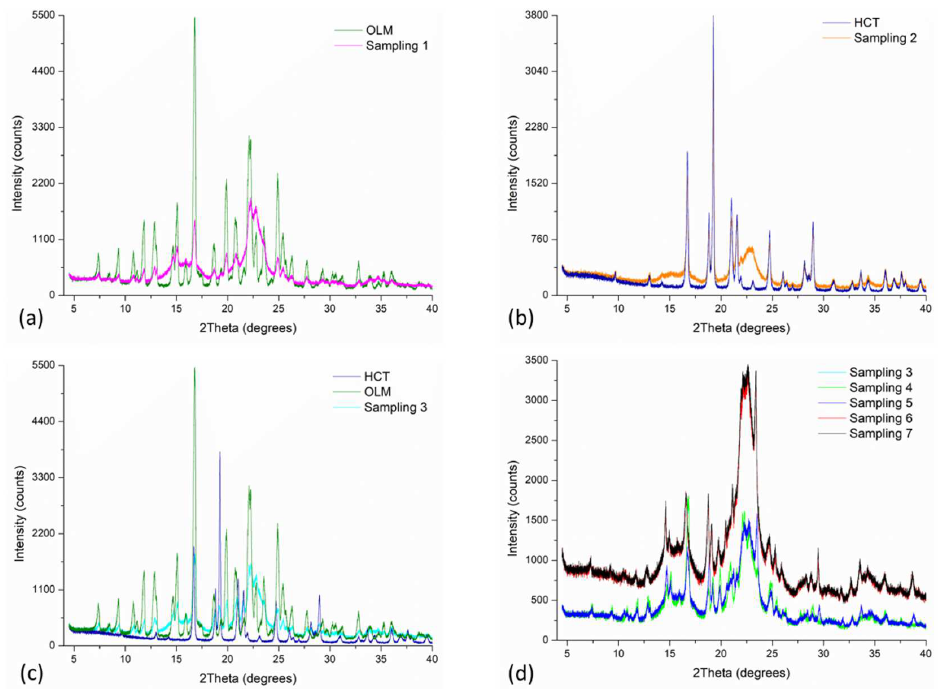
Figure 3. Experimental PXRD patterns of each sampling of F 1 : ( a ) OLM and sampling 1 (i.e., OLM + MC), ( b ) HCT and sampling 2 (i.e., HCT + MC), ( c ) OLM, HCT and sampling 3 (i.e., sampling 1 + 2), ( d ) Sampling 3 and samplings from 4–7.